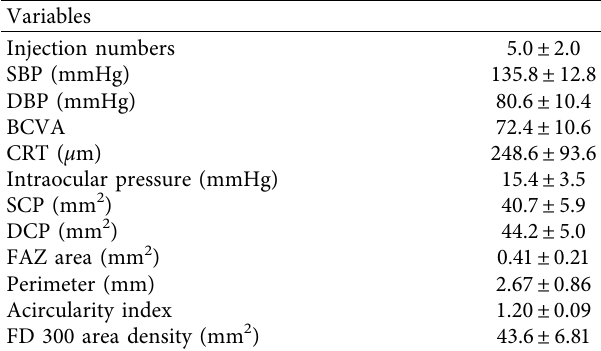
Table 2: The data of participants at the last